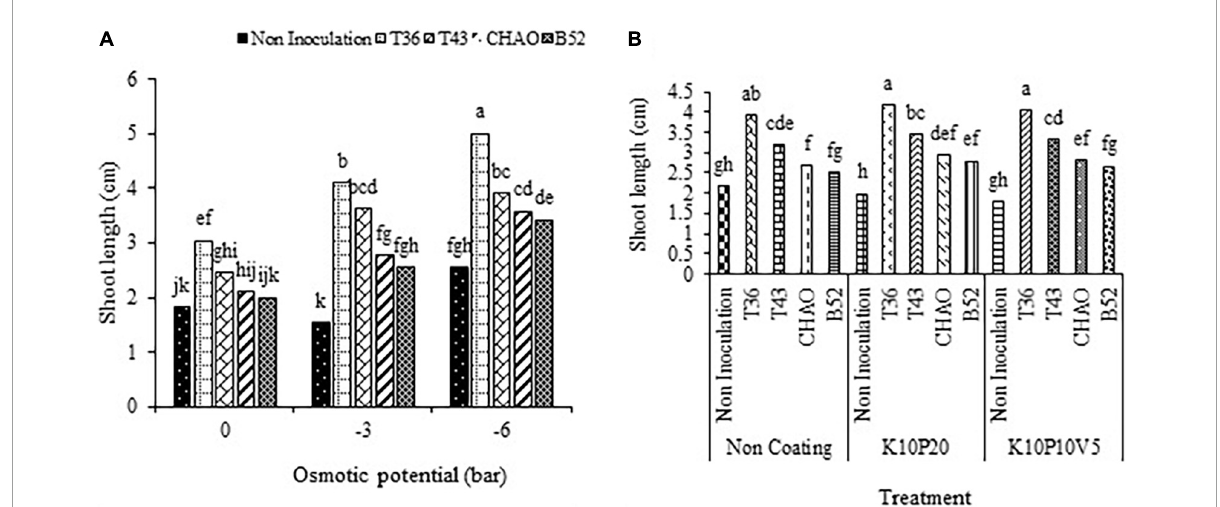
FIGURE9 Mean comparison of the effect of seed inoculation on seedling shoot length (in cm) of anise at different levels of (A) drought stress and (B) coating treatments. Means with the same letter are not significantly different according to the HSD test at P = 0.05. CHA0, B52 of Pseudomonas fluorescens , T36 and T43 of Trichoderma harzianum isolates. K, kaolin; V, vermiculite; P,